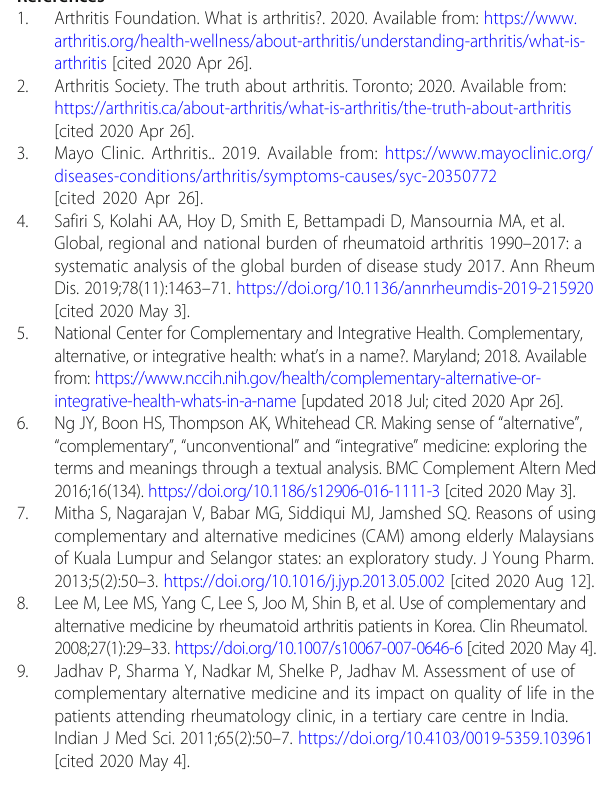
Abbreviation CAM: Complementary and alternative